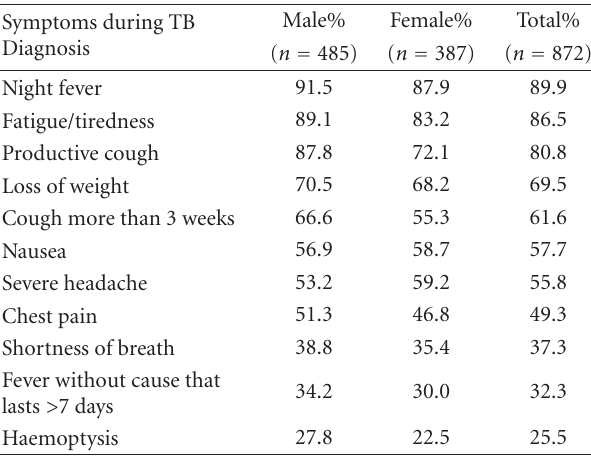
Table 3: Symptoms experienced during TB diagnosis.